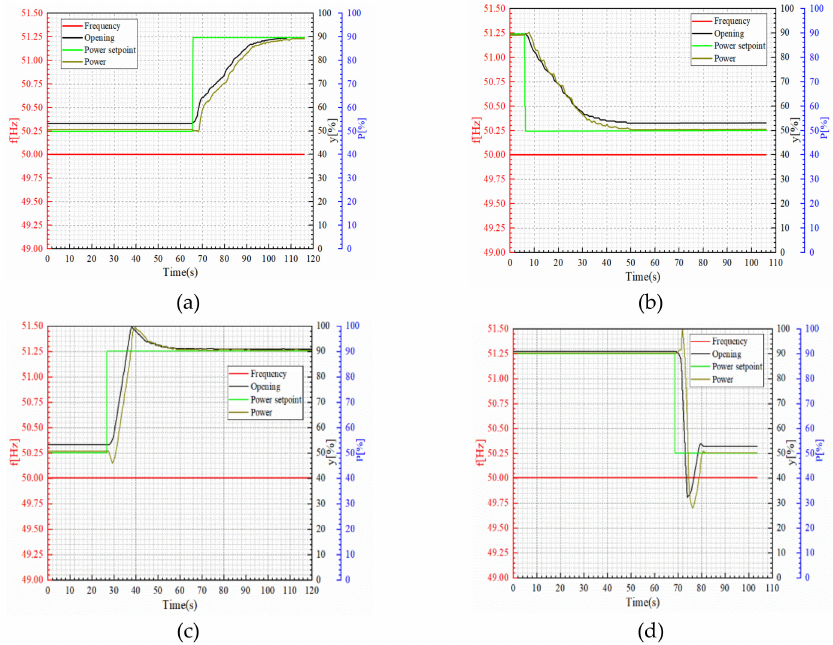
Figure 11. Power regulation with 40% rated power change. ( a ) Increase power by the S-curve control strategy; ( b ) Reduce power by the S-curve control strategy; ( c ) Increase power by the conventional linear control strategy; ( d ) Reduce power by the conventional linear control